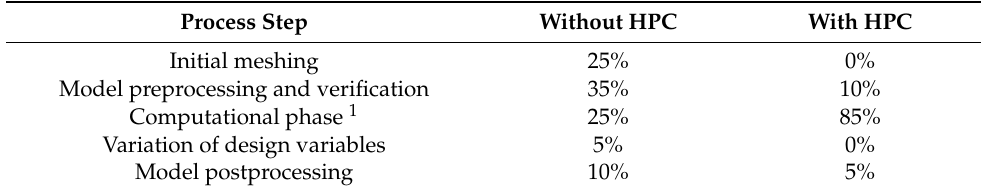
Table 2. Estimated rel. temporal expenditure for design iterations w/o and w/